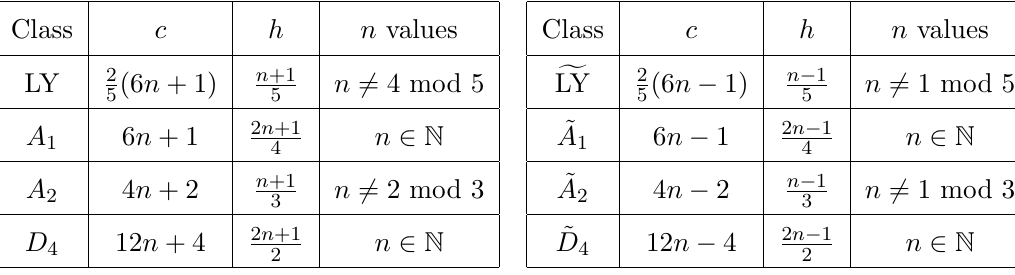
Table 4 . Quasi-characters with ‘ = 0, ‘ =